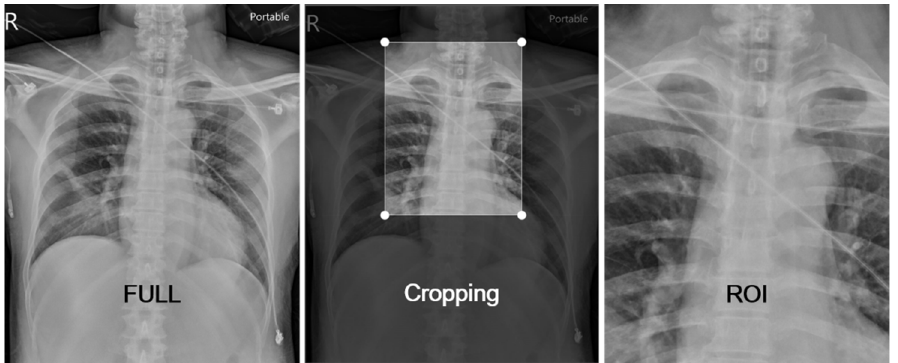
Figure 2. Manual cropping to produce ROI images, including the four landmarks (right clavicle head, left clavicle head, carina, ETT tip).